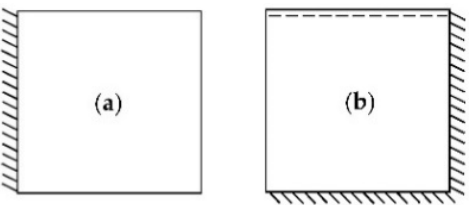
Figure 3. Ways of supporting the analyzed plates: ( a ) Plate clamped on one edge; ( b ) Plate clamped on two adjacent edges and simply-supported on the third edge.